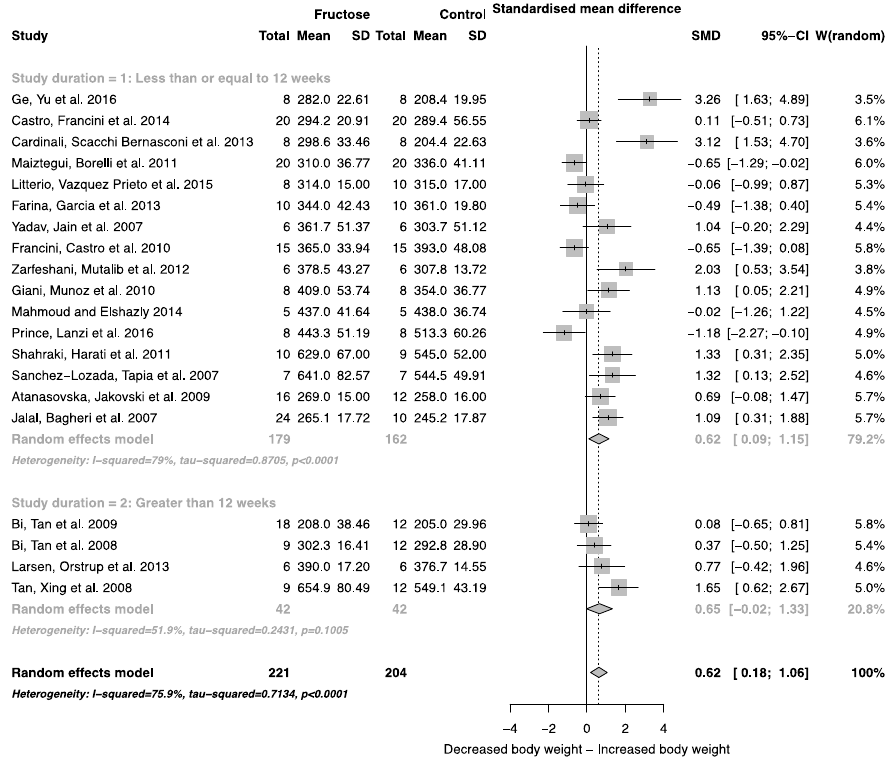
Figure 2. Forest plots of the effect of fructose consumption on adult male rodent body weight (mean and standard deviation (SD), split by study duration. The pooled effects estimates are represented by three diamonds; one for studies of 12 weeks or less, one for studies of greater than 12 weeks, and one representing the combined effect. Data are presented as standardized mean differences (SMD) with 95% confidence interval (CI). p ‐ Values are for the inverse variance random effects models with DerSimonian ‐ Laird estimator for Tau 2 . Inter ‐ study heterogeneity was tested by Cochran’s Q at a significance of p < 0.10 and quantified by I 2